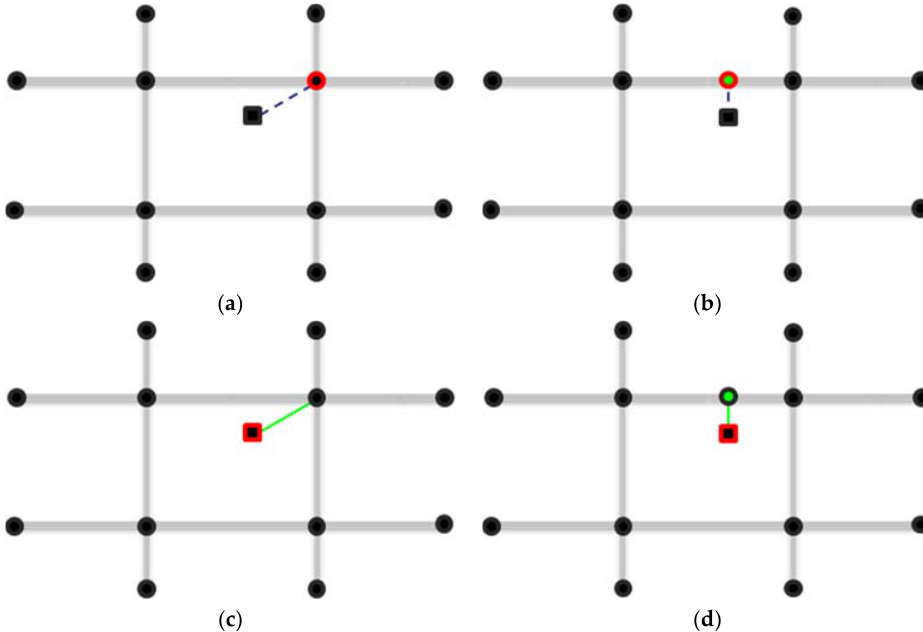
Figure 9. Four strategies to integrate points/locations within the spatial network. ( a ) Strategy 1: represent each point with its nearest vertex; ( b ) Strategy 2: represent each point with its nearest geometric point; ( c ) Strategy 3: add a pseudo edge (colored green) between each point and its nearest vertex; ( d ) Strategy 4: Add a pseudo edge (colored green) between each point and its nearest geometric point.